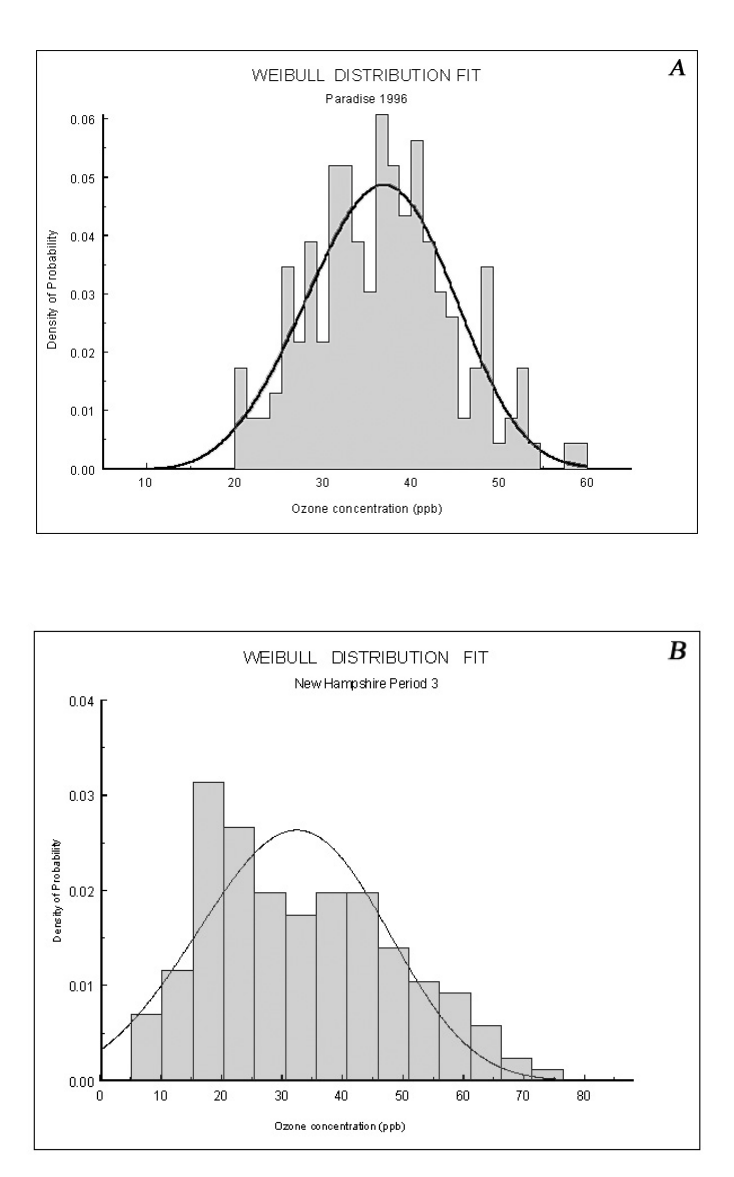
FIGURE 1. (A) Fit of the Weibull frequency plot for the hourly O 3 concentrations from continuous measurements during June 26– August 28, 1996. Although at the outset, the shape of the distribution may look normal and "bell-shaped", note the shift in the curve from left to right on the horizontal axis. ( B) Same as (A), Mt. Washington, New Hampshire, July 19–26, 1994. (3) In order to fit the Weibull distribution, estimation of its parameters (shape, scale, and